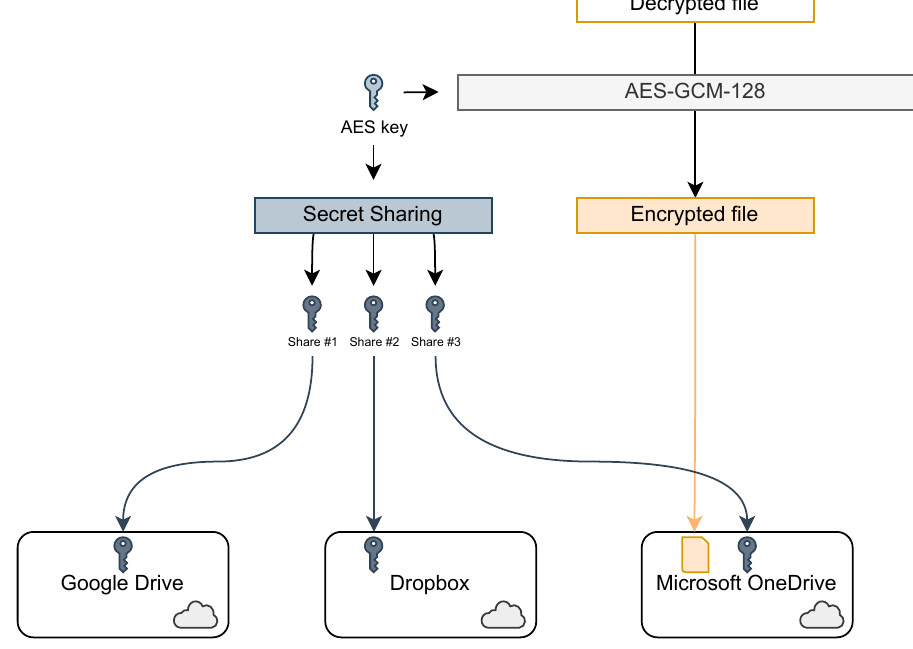
Figure 1. File uploading scheme in the Datachest